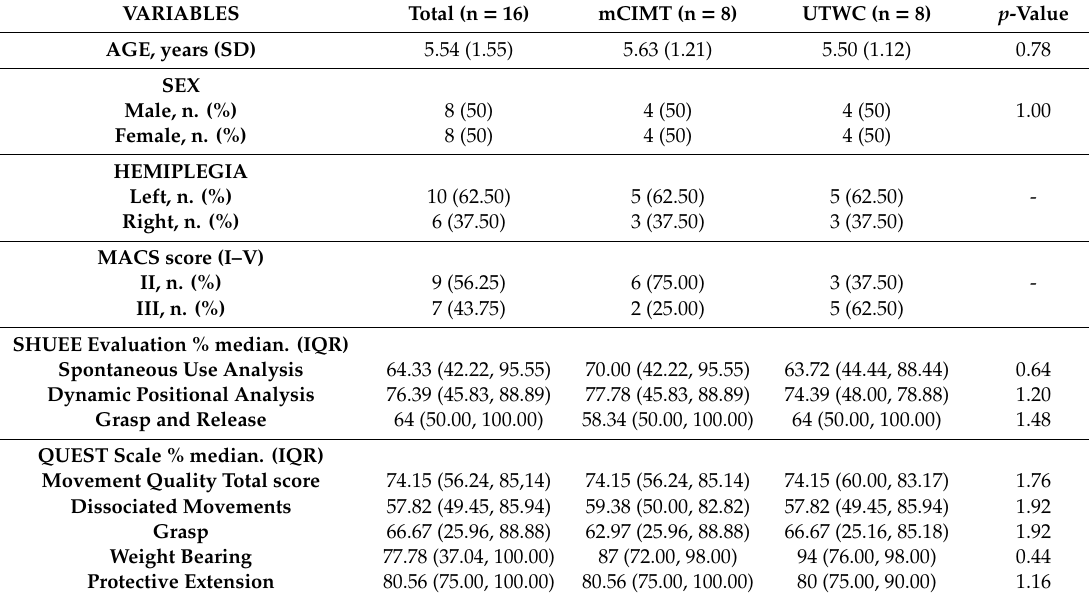
Table 1. Baseline measurements per group and total